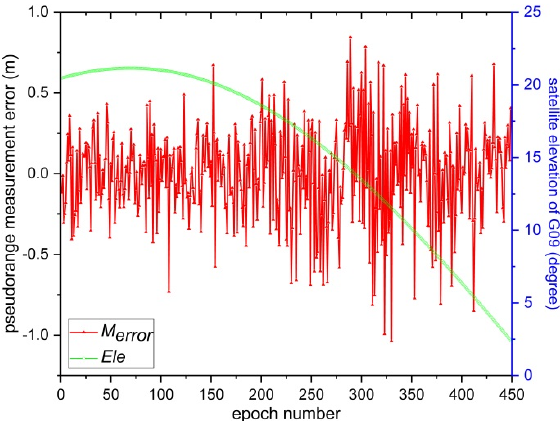
Figure 3. Elevation and pseudorange measurement error sequence of satellite G09.